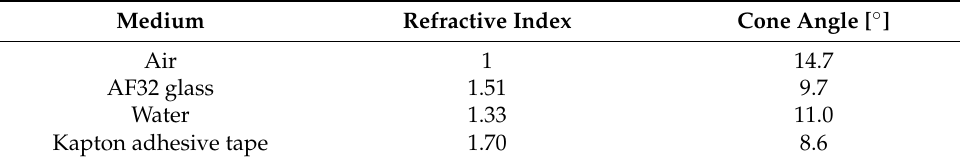
Table 2. Refractive index and cone angles of the Bessel beam in different media.